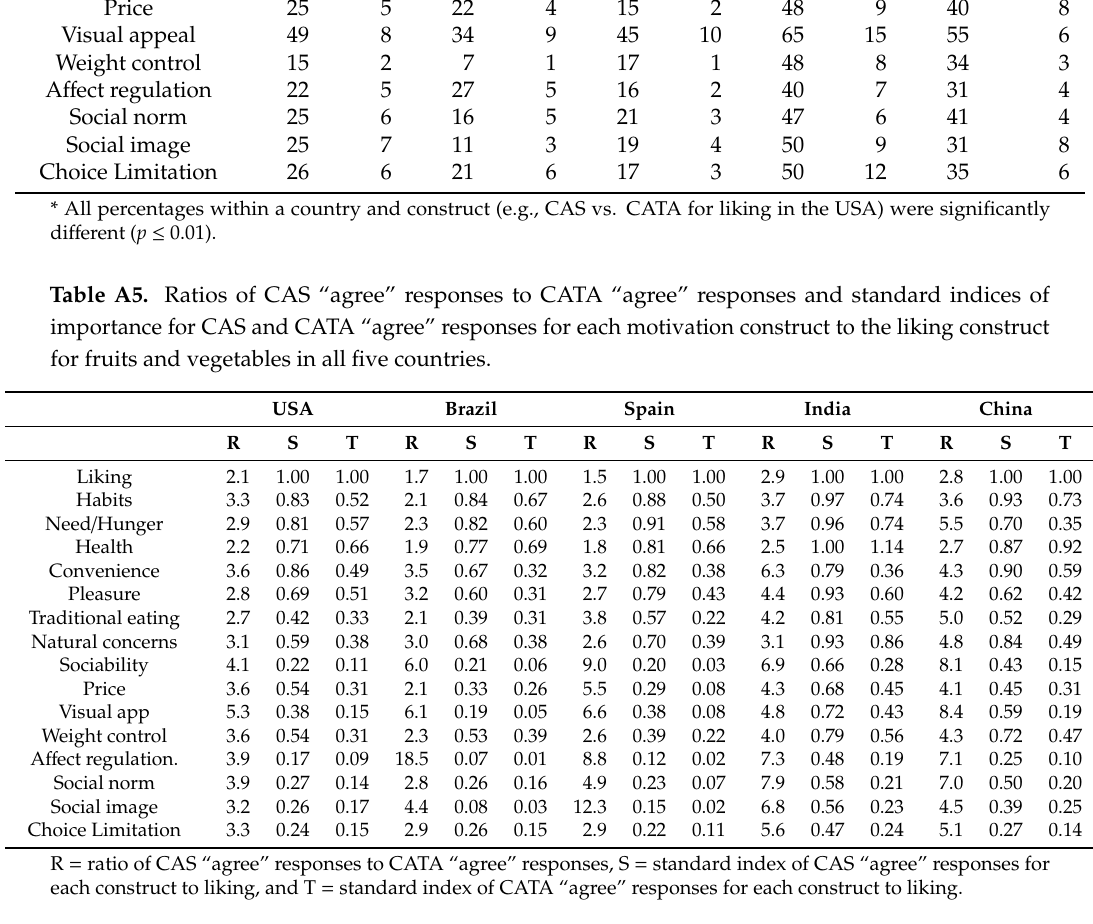
Table A6. Ratios of CAS “agree” responses to CATA “agree” responses and standard indices of importance for CAS and CATA “agree” responses for each motivation construct to the liking construct for starch-rich foods in all five